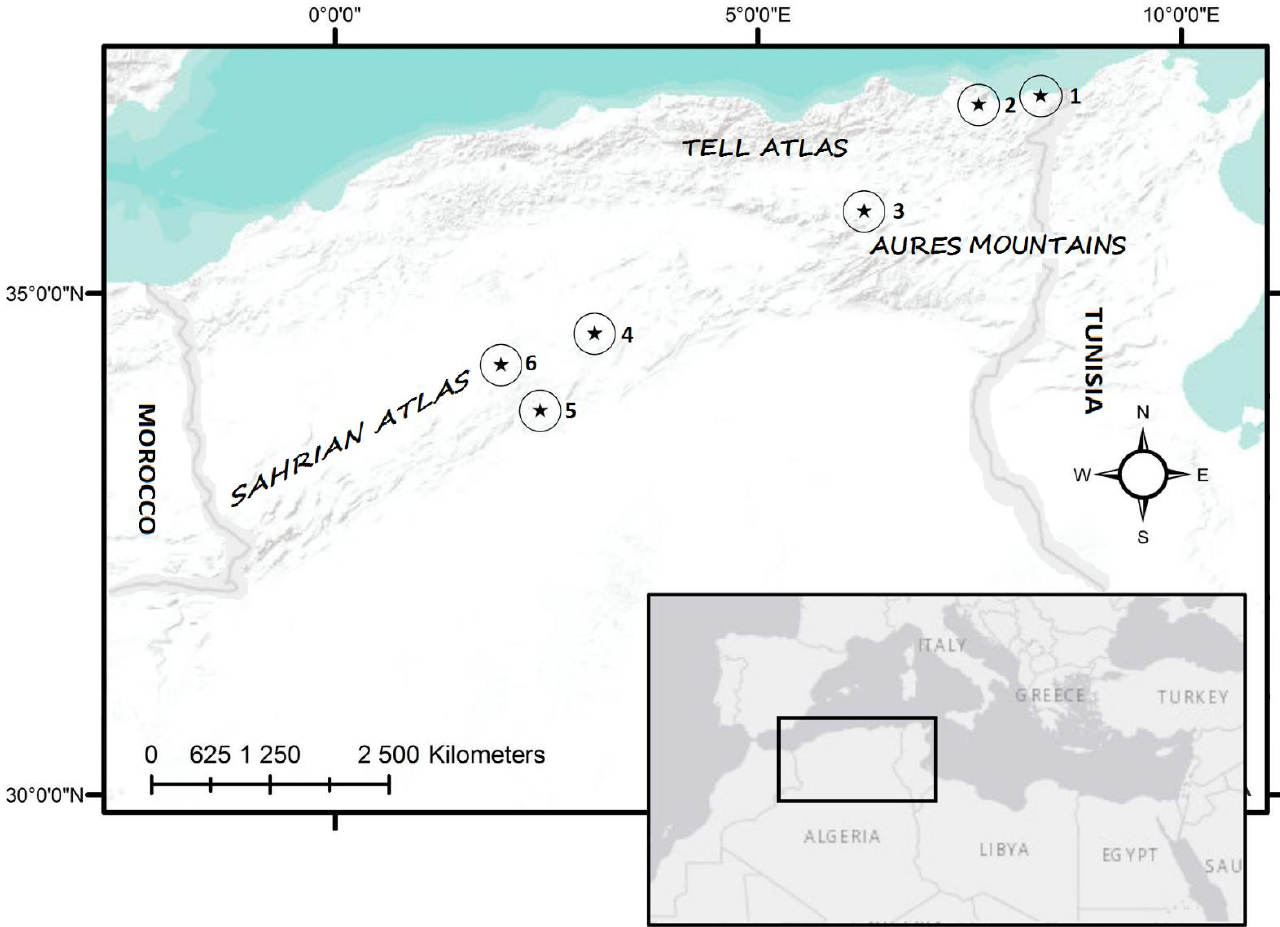
Figure 1. Placement of the studied localities: 1 – El Kala (Boumalek); 2 – Annaba (Hadjar Eddis); 3 – Batna (Ain Yagout); 4 – Djelfa (Senalba Chergui); 5 – Laghouat (Tadjmout); 6 – Aflou (Gueltet Sidi Saad).